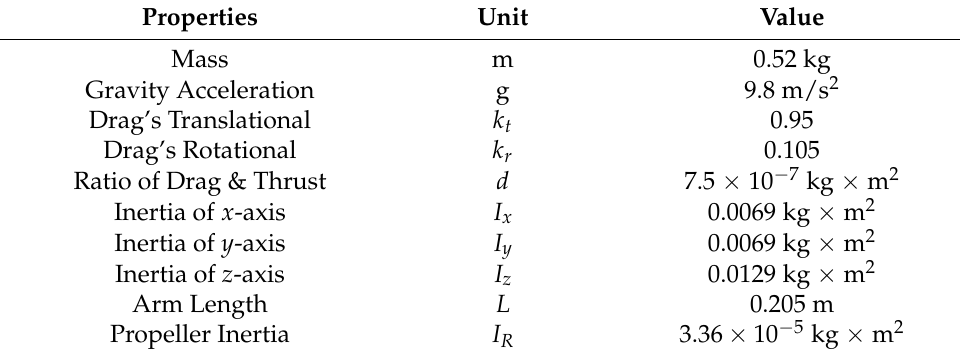
Table 2. The quadrotor model parameters.